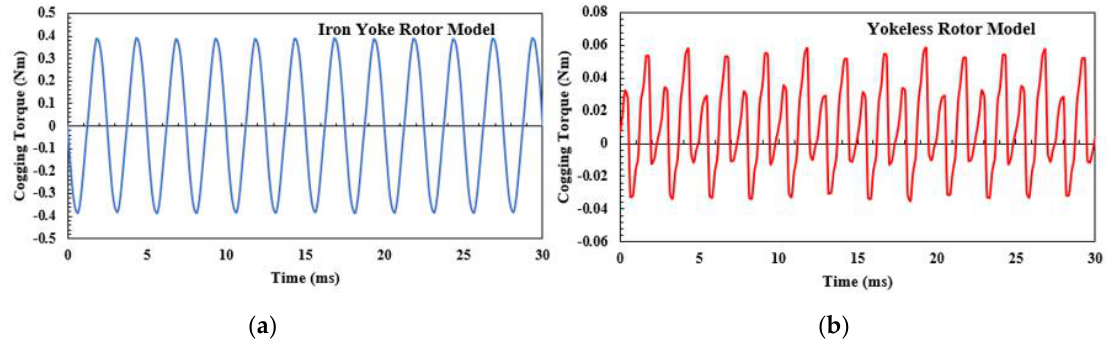
Figure 10. Cogging torque comparison in DARF-PMVM: ( a ) iron rotor yoke model, ( b ) yokeless rotor model.